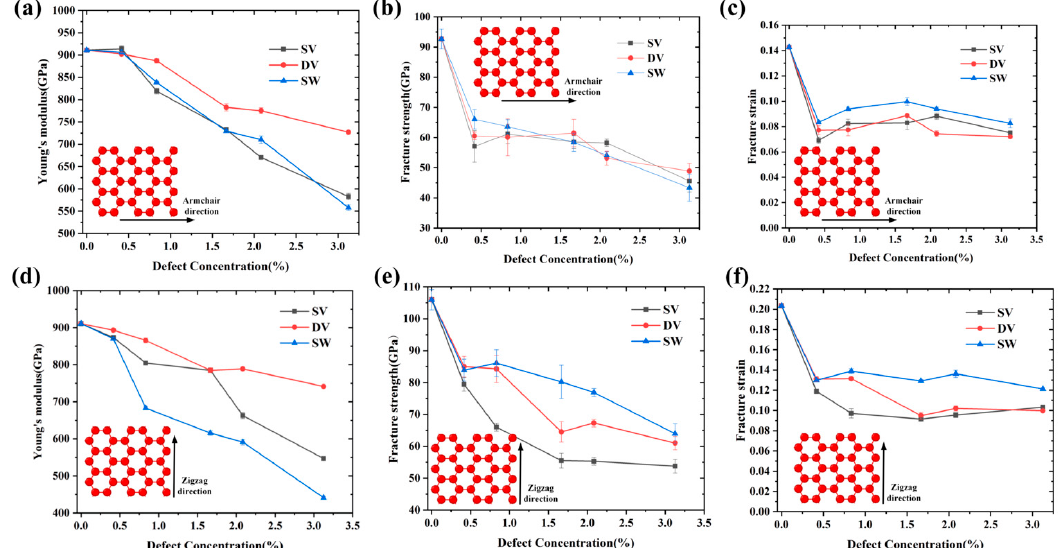
Figure 9. Under different defect types and concentrations, the variations of: ( a ) Young’ modulus; ( b ) fracture strength; and ( c ) fracture strain of Gr along the armchair direction. The variations of: ( d ) Young’ modulus; ( e ) fracture strength; and ( f ) fracture strain of Gr along the zigzag direction with respect to defect concentration at different defect types.